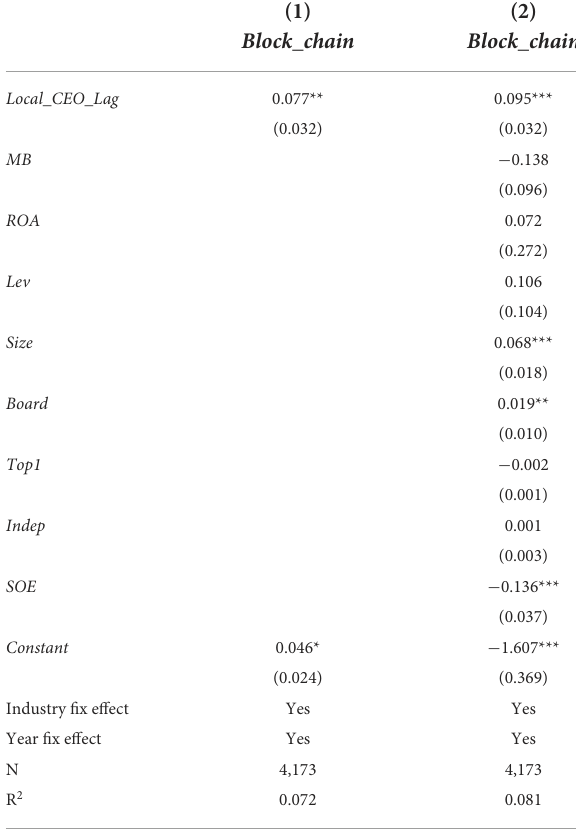
TABLE 4 Robustness check: Lag of local CEO. TABLE 5 Robustness check: Altering the measurement of local